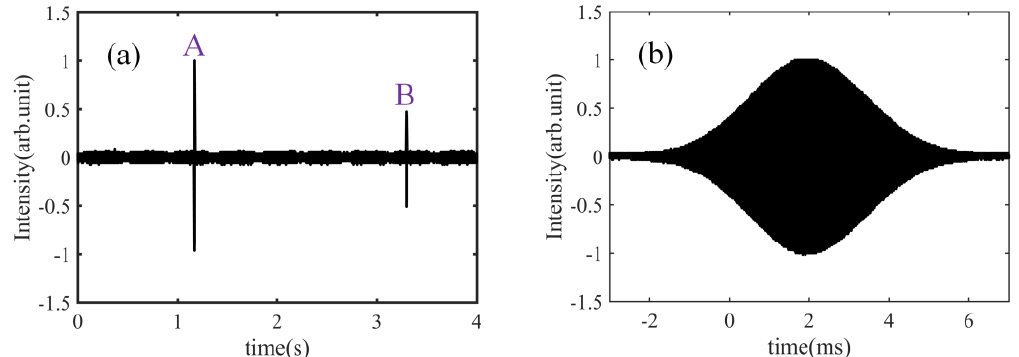
Figure 5. ( a ) Cross-correlation patterns corresponding to the reference mirror and the measurement mirror, with water in the container; ( b ) detailed observation of the cross-correlation pattern, with water in the container.